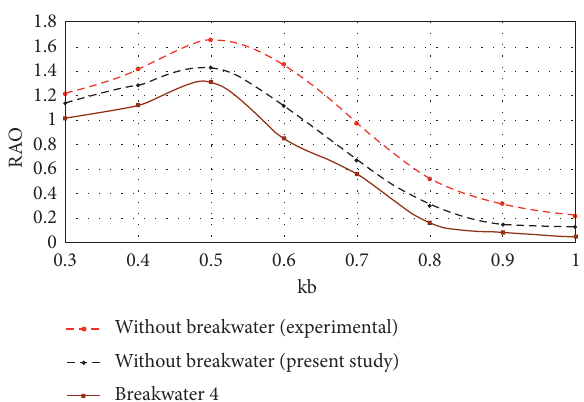
Figure 16: RAO curve for a heaving pontoon, with and without breakwater number